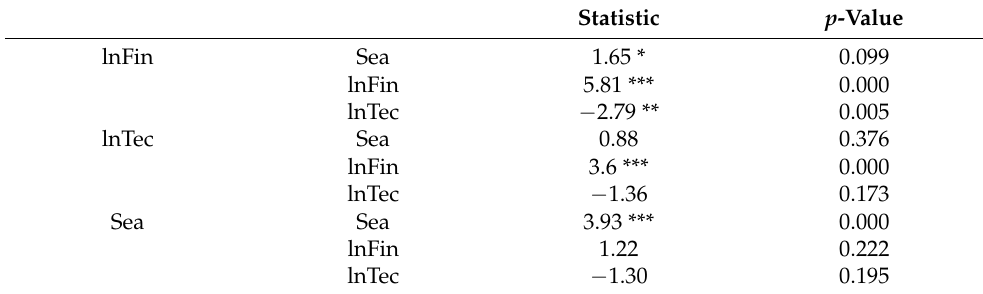
Table 7. GMM test results.